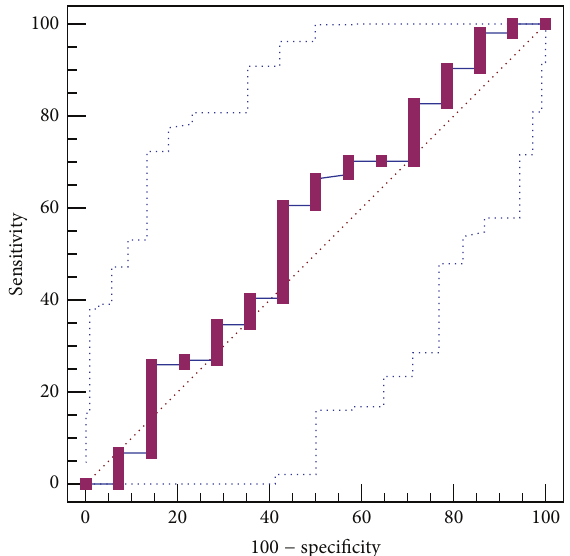
Figure 1: ROC curve analysis to identify the discriminative capacity of HA level in predicting the presence of GEVs in liver cirrhosis.